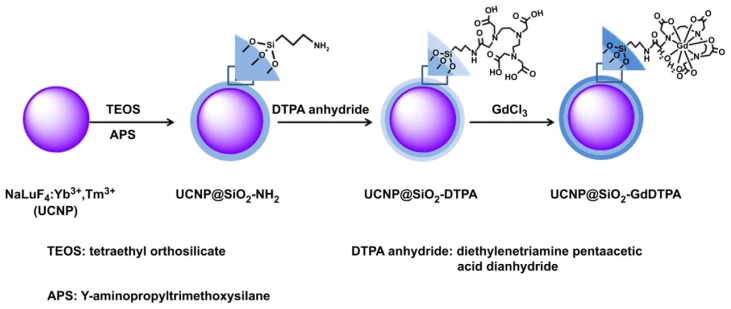
Schematic representation of the synthetic route of NaLuF4@SiO2-GdDTPA nanoparticles (UCNP@SiO2-GdDTPA) (adapted from Xia et al. 2012 [64], Copyright 2012 Elsevier Ltd. and reproduced with permission).